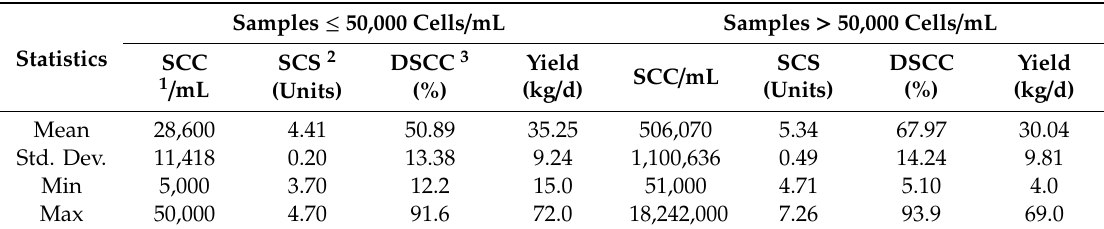
Table 2. Descriptive statistics of total and di ff erential somatic cell counts classified by SCC (threshold ≤ 50,000 /> 50,000 cells / mL).